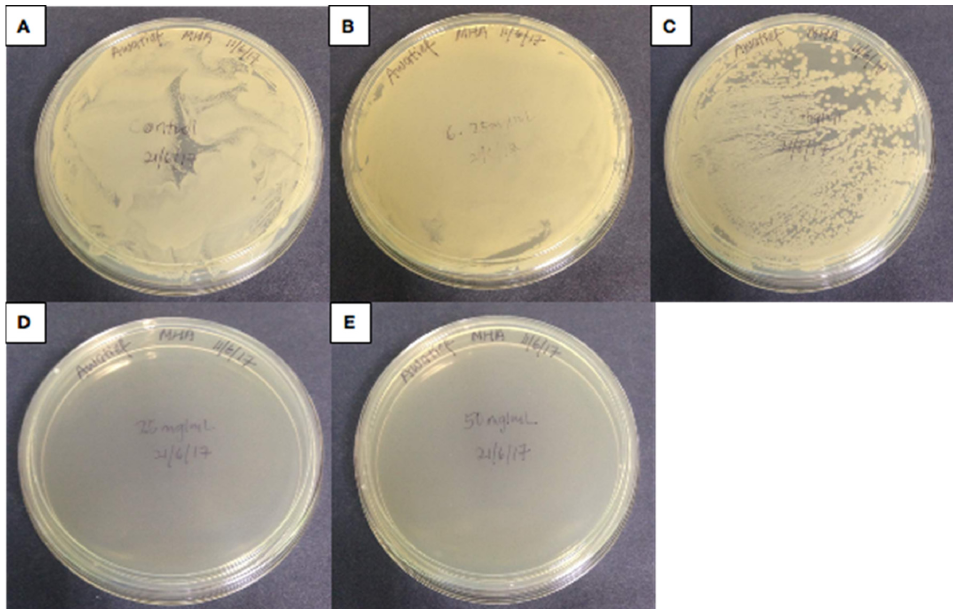
Figure 5. K . pneumonia . Negative control ( A ). 6.25 mg/mL TiO 2 containing 0.03% silver ( B ). 12.5 mg/mL TiO 2 containing 0.03% silver ( C ). 25 mg/mL TiO 2 containing 0.03% silver ( D ). 50 mg/mL TiO 2 containing 0.03% silver ( E ). It should be noted